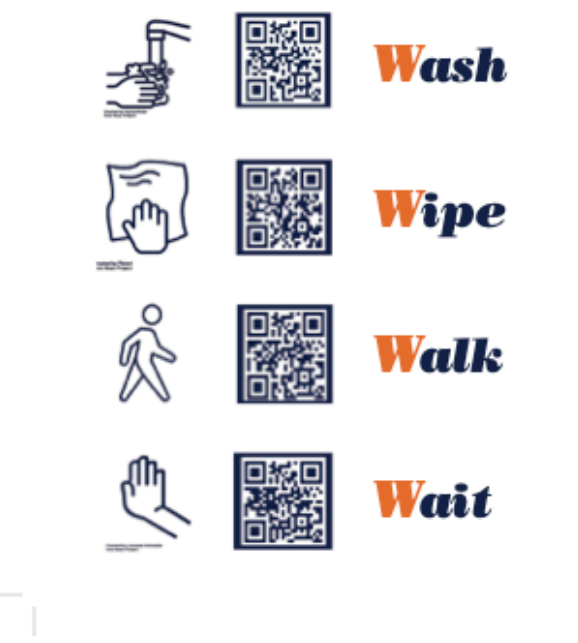
Figure 2. Pocket Guide with Quick Response Codes.